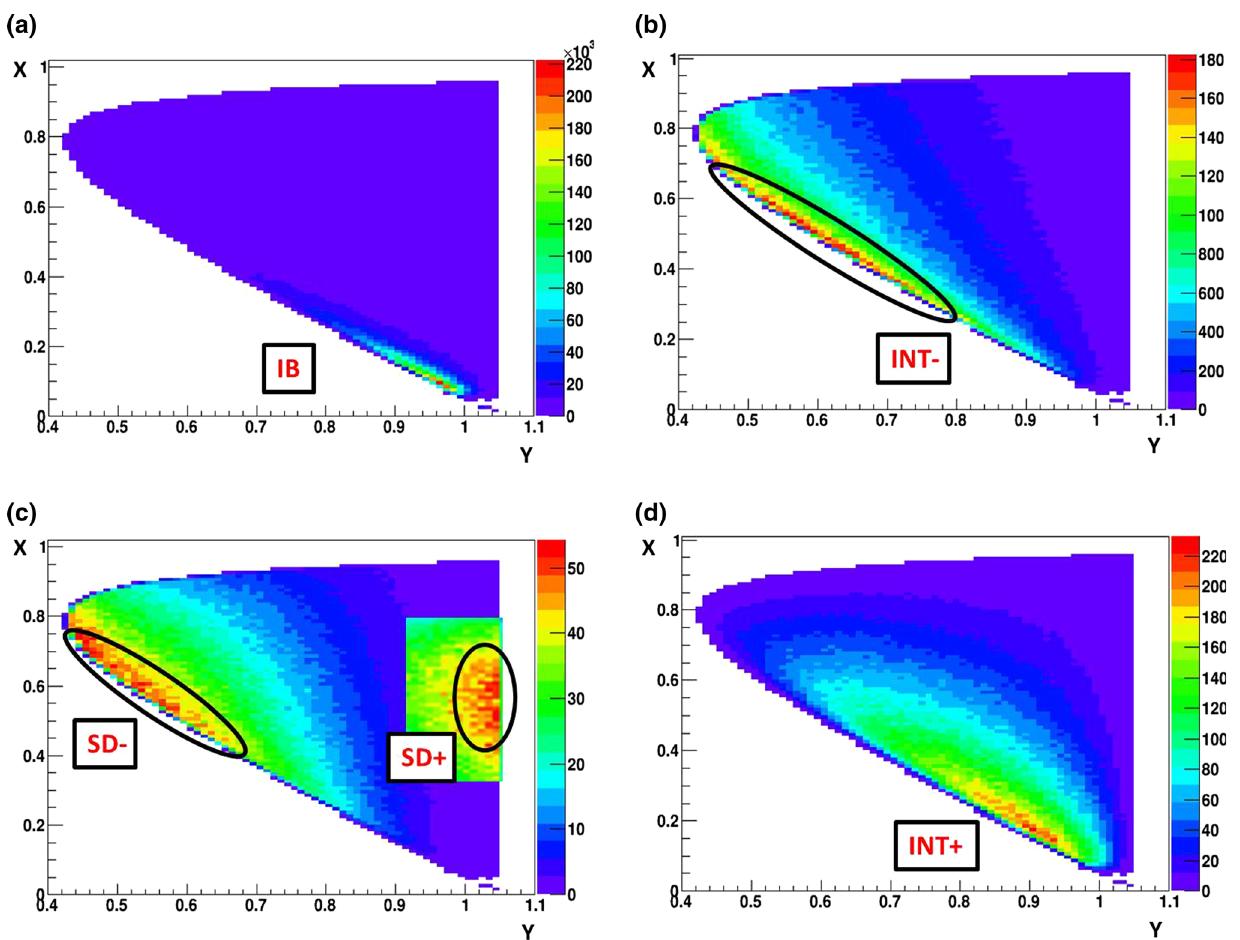
Fig. 1 Distribution over the Dalitz-plot ( y , x ) for the different terms, contributing to the decay rate as described in Sect. 1: a f IB ( x , y ) , b